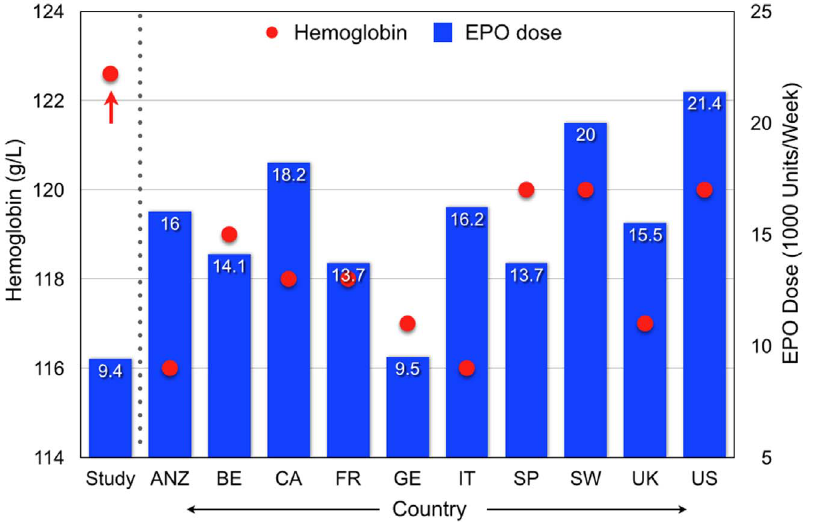
Figure 9. EPO dose and Hb in 2005–2008 in ten countries [26] and in the study unit (Study) in February–July, 2011. (Abbreviations: ANZ= Australia and New Zealand; BE= Belgium; CA= Canada; Fr= France; GE= Germany; IT= Italy; SP= Spain; SW= Sweden; UK= United Kingdom; US= United States).